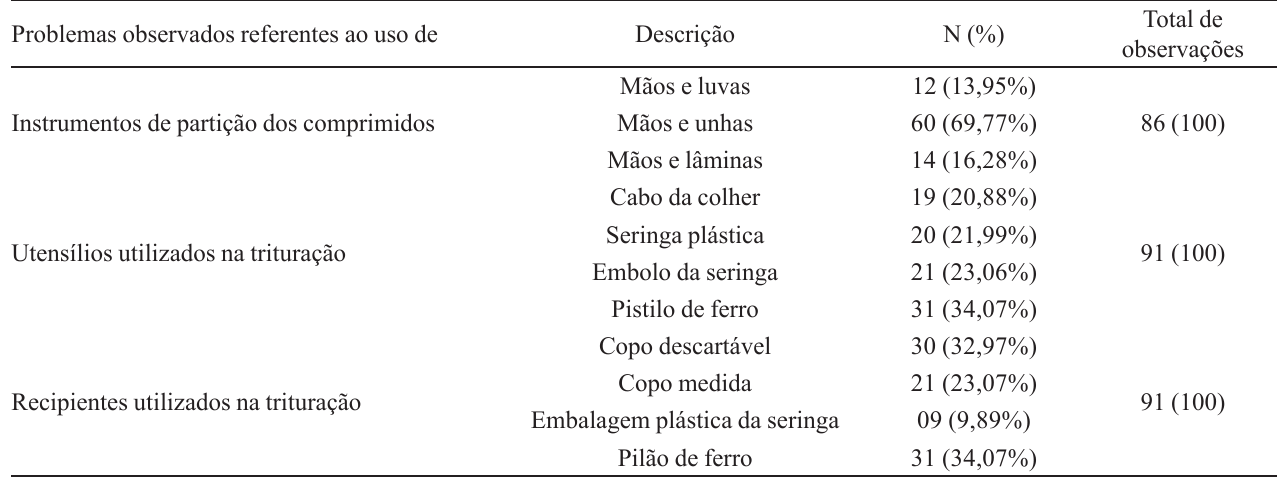
TABELA III - Problemas observados durante o preparo dos MP sólidos, em posto de enfermagem (Fortaleza-CE, dezembro/2004 a